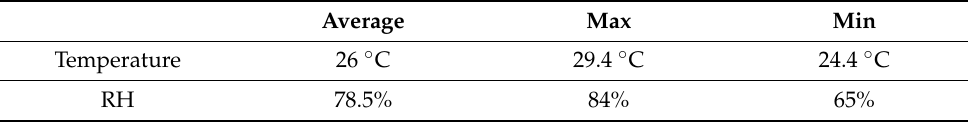
Table 7. Statistics of indoor environmental parameters in